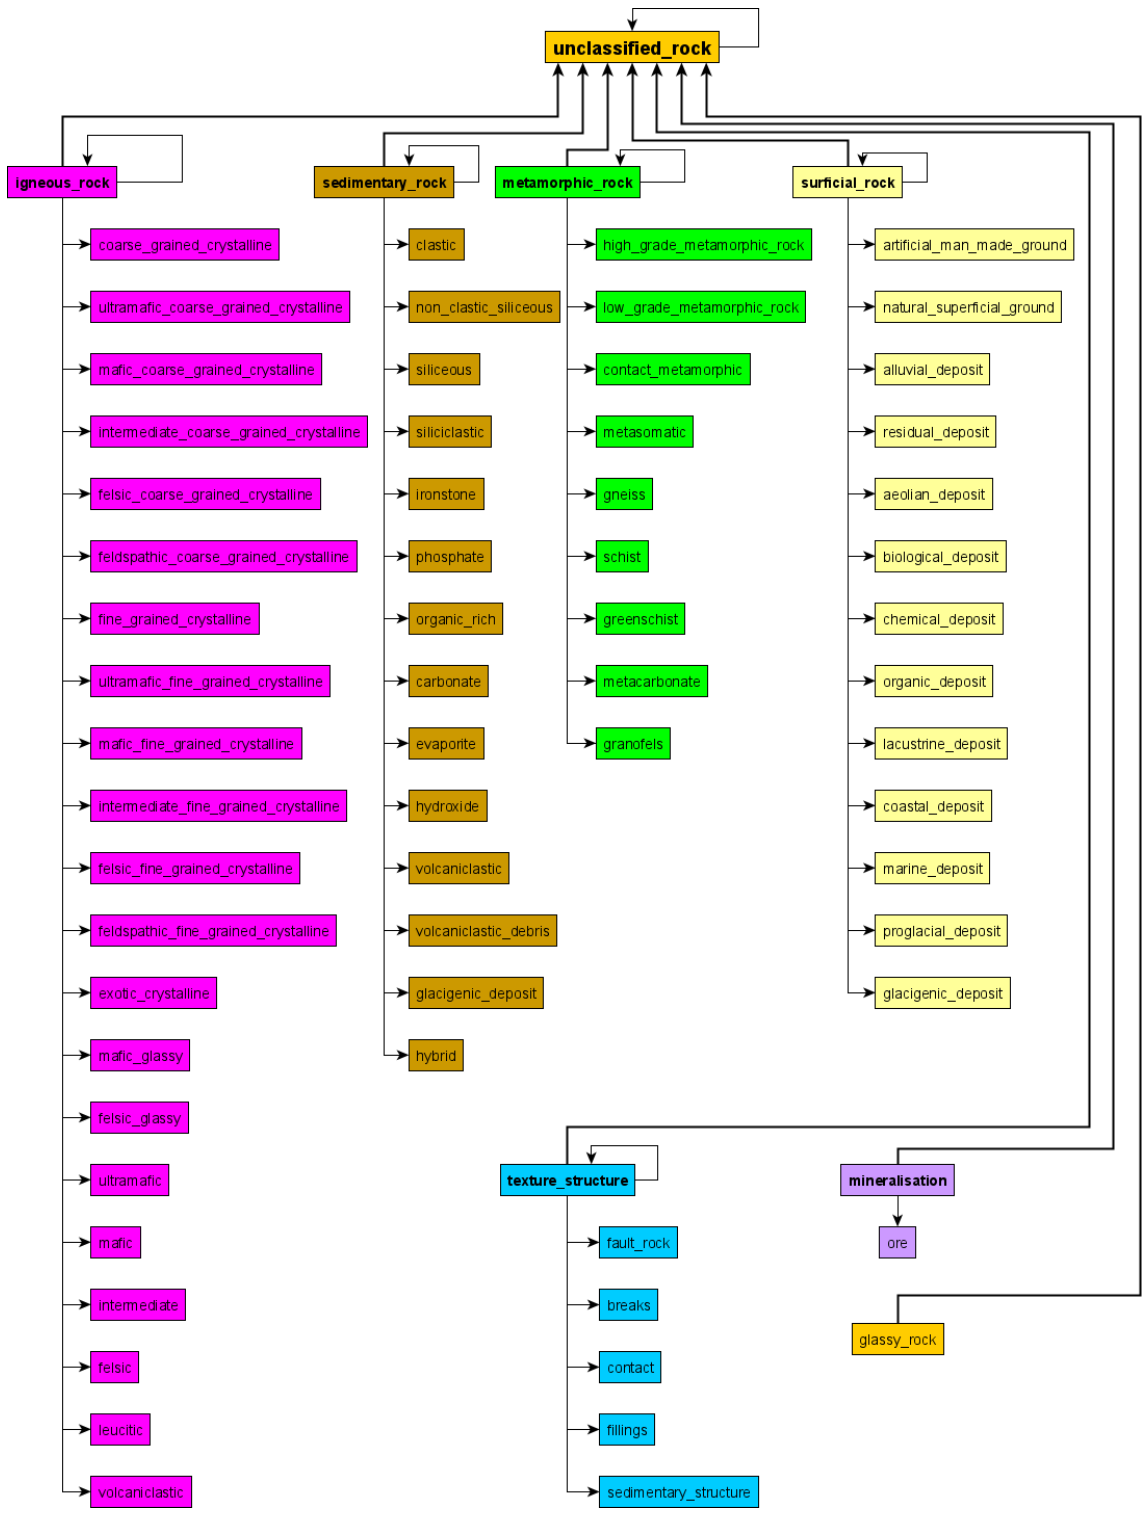
Figure 1. Lithology Hierarchical Thesaurus showing the seven major Lithology_Groups : igneous rocks (pink), sedimentary rocks (light brown), metamorphic rocks (green), surficial rocks (light yellow), texture and structure (blue), mineralization (purple) and unclassified rocks (dark yellow) and their corresponding Lithology_Subgrouups